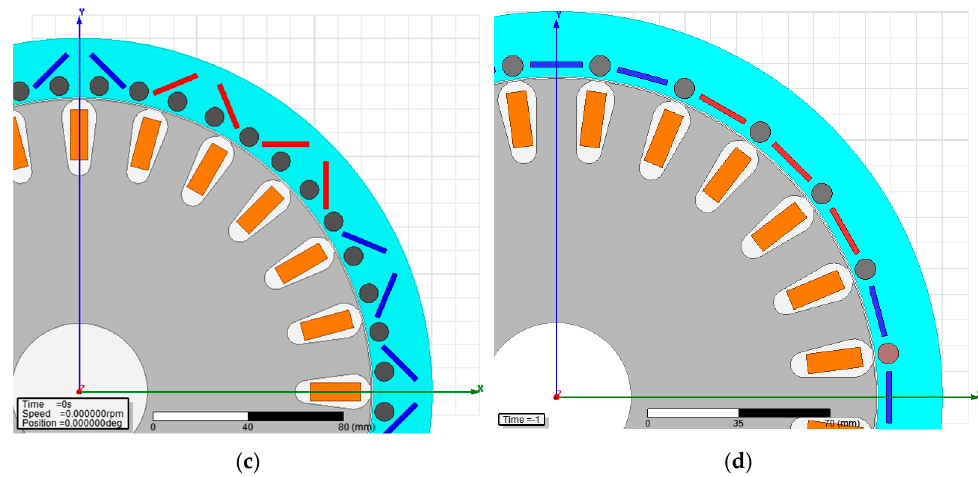
Figure 2. Rotor types for di ff erent alignments and orientations of the magnets with bars. ( a ) Type-A: Axial alignment., ( b ) Type-B: Radial alignment, ( c ) Type-C: Cross alignment, ( d ) Type-D: Axial alignment with bar in-lined.